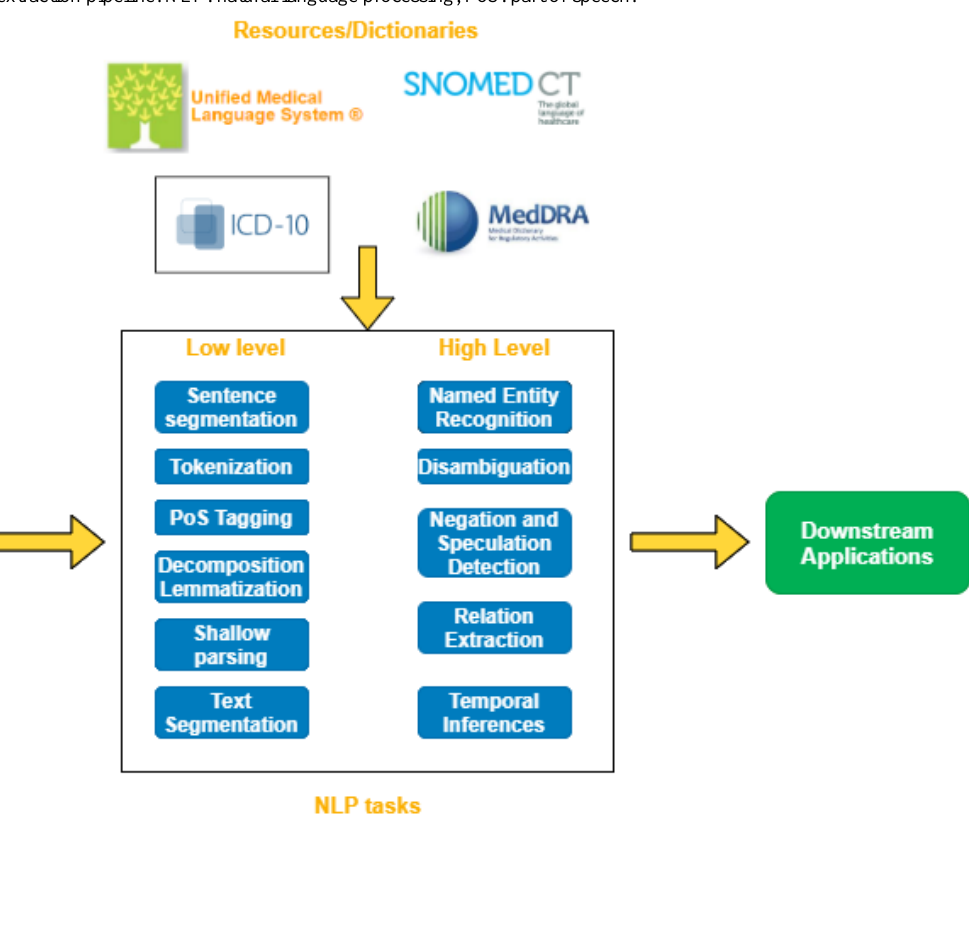
Figure 1. Typical information extraction pipeline. NLP: natural language processing; PoS: part of